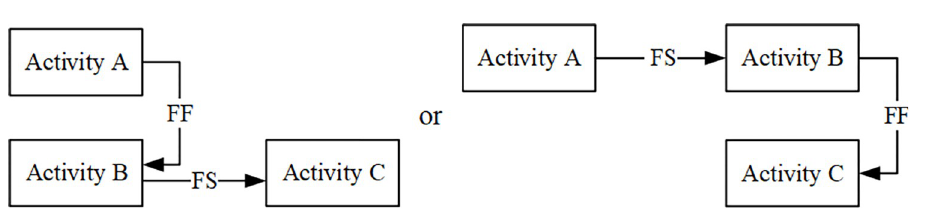
Fig 3. The relationship of